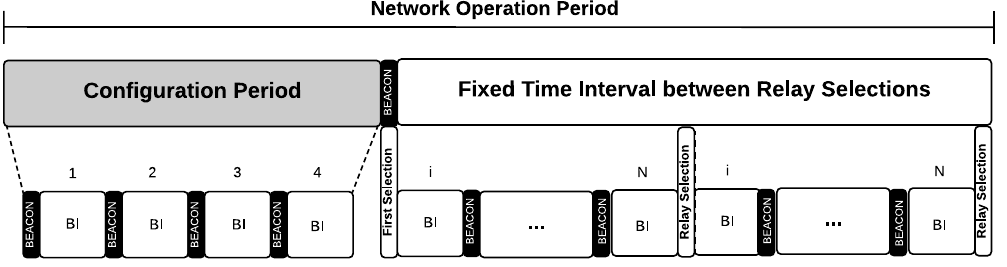
Figure 8. Operation of the periodic relay selection